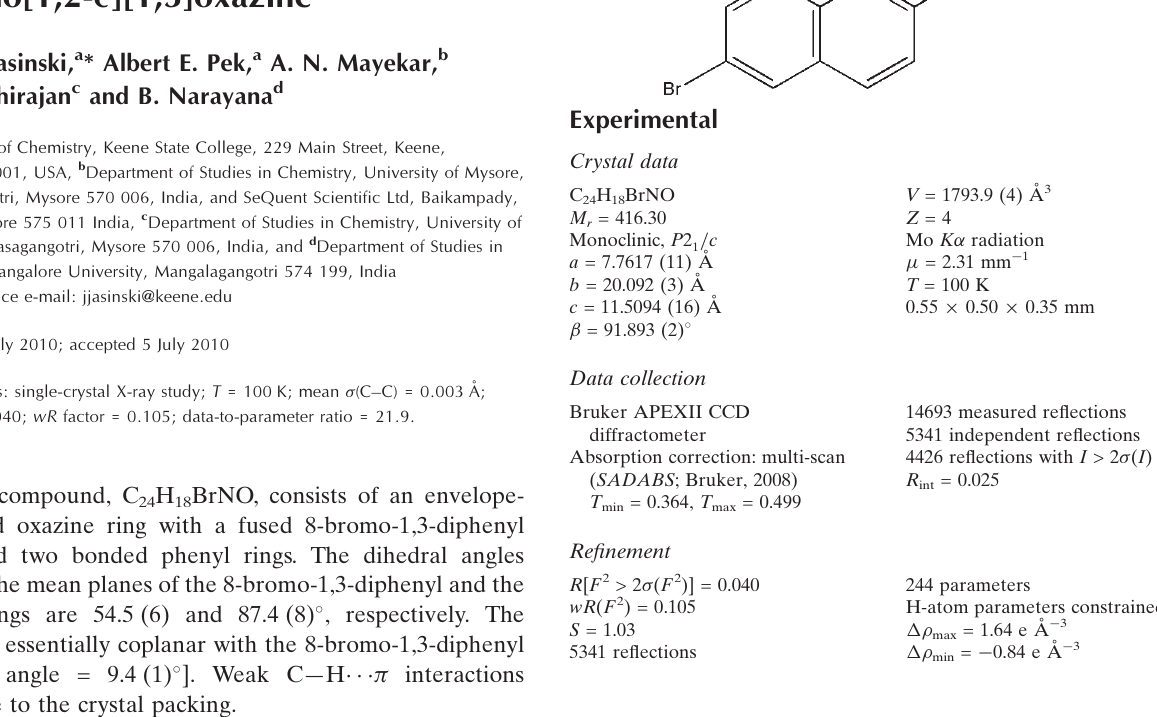
Bruker APEXII CCD diffractometer Absorption correction: multi-scan ( SADABS ; Bruker, 2008) T min = 0.364, T max = 0.499